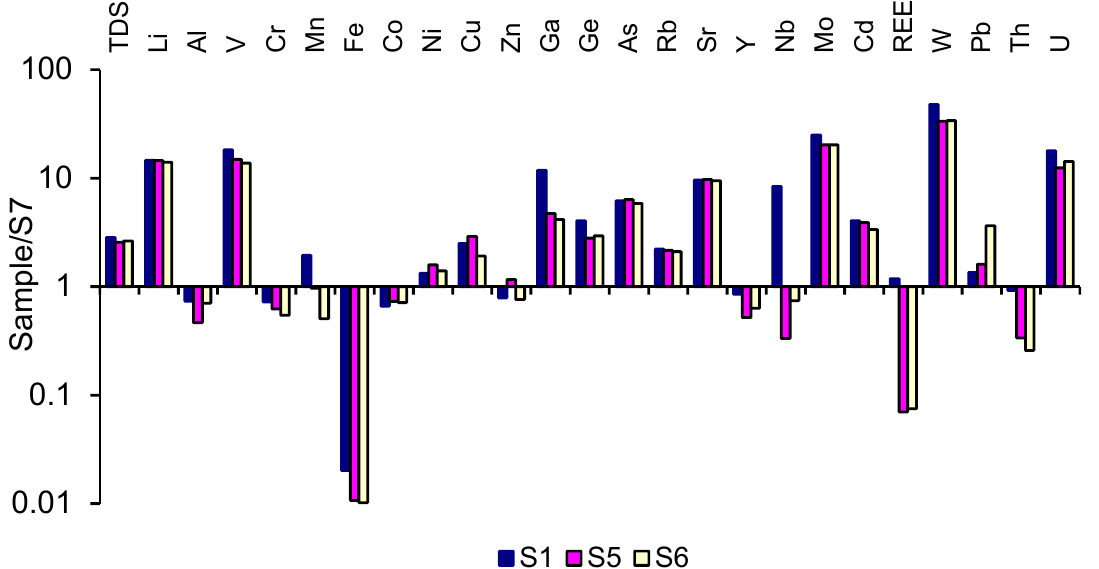
Figure 6. The distribution of the concentration ratios at different sampling sites. The highest obtained values were for W (33.6–47.7), Mo (20–24.9), V (13–18), U (12.4–17.8), Li (14–14.6), Sr (9.4–9.7), and Ga (94.1–11.8). The water of the lake was extremely